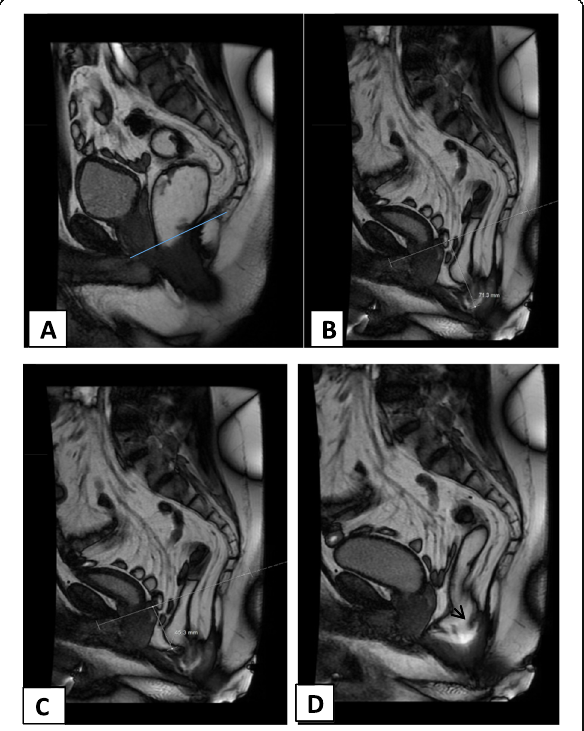
Fig. 4 Mid-sagittal SSFP obtained ( a ) at rest and ( b – d ) during defecation showing severe rectal descent (7 cm), moderate enterocele (4.5 cm) with evidence of full-thickness intussusception